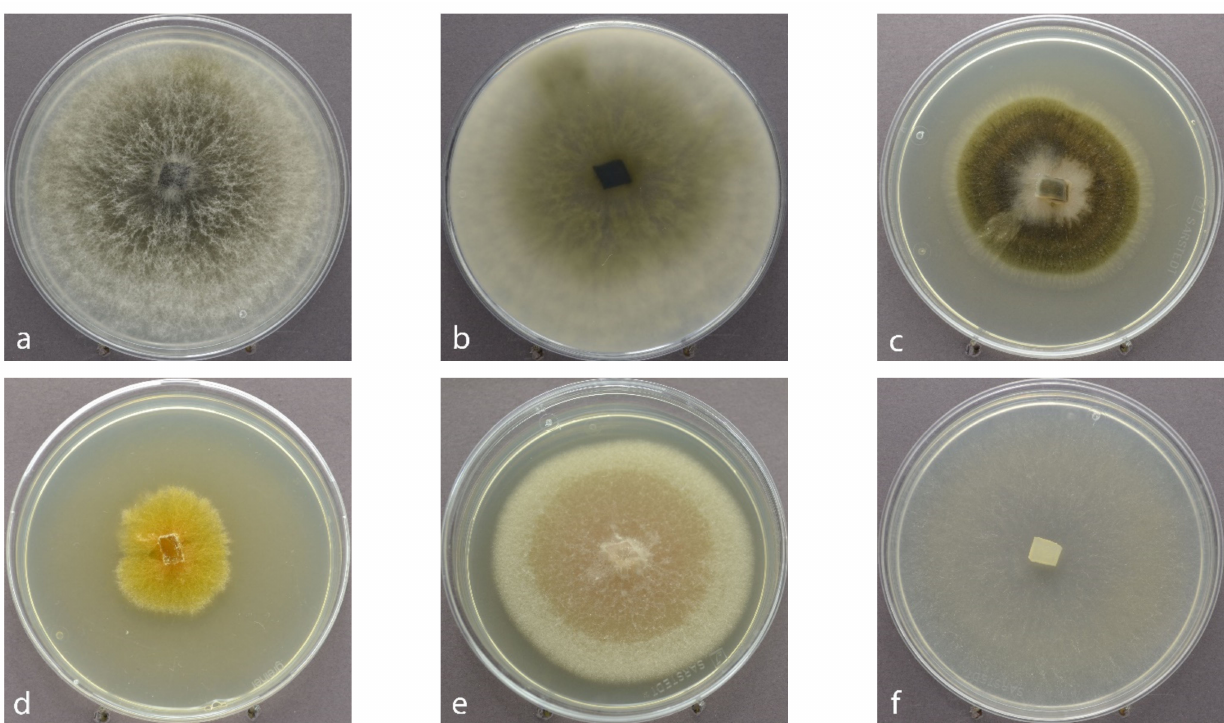
Figure 2. Most frequently isolated endophytes of Scots pine twigs, cultivated on MYP in 90 mm Petri dishes, seven days in ambient daylight at room temperature, at around 22 ◦ C: ( a ) Sphaeropsis sapinea obvers; ( b ) Sphaeropsis sapinea revers; ( c ) Sydowia polyspora ; ( d ) Truncatella conorum-piceae ; ( e ) Microsphaeropsis olivacea ; ( f ) Desmazierella acicola